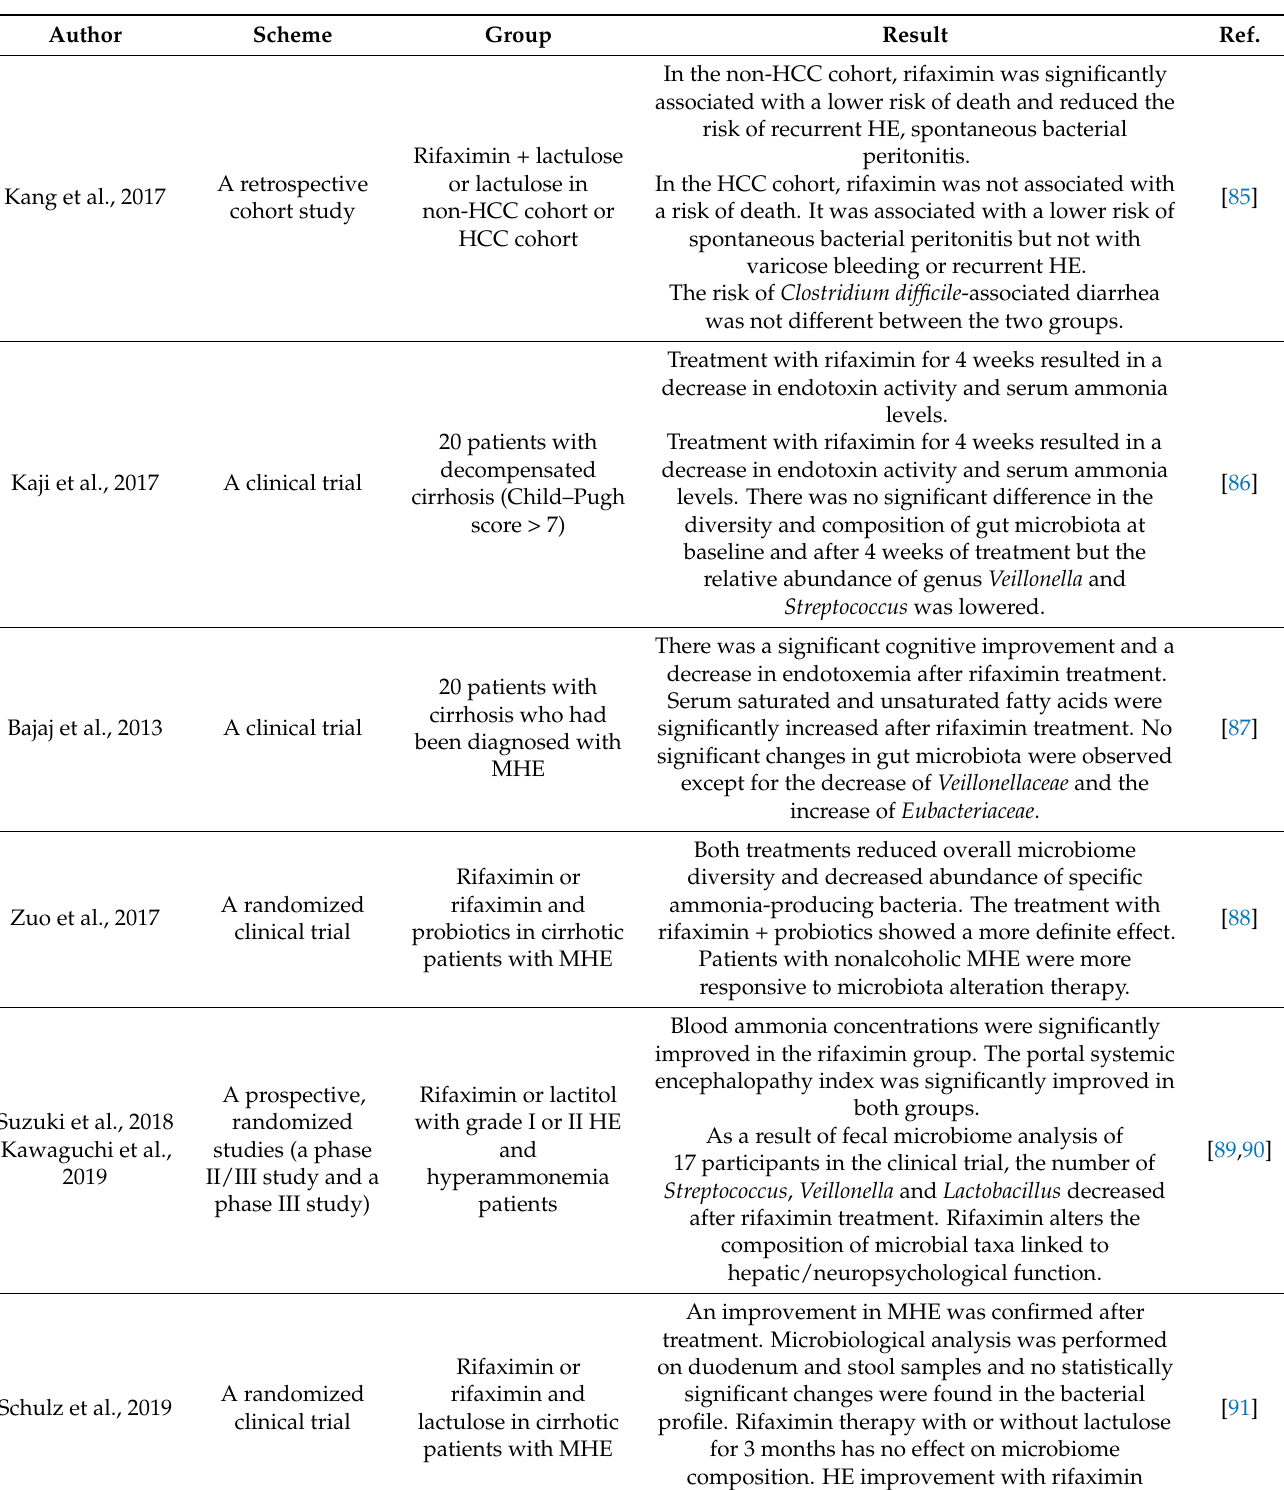
Table 4. Antibiotics therapies for hepatic